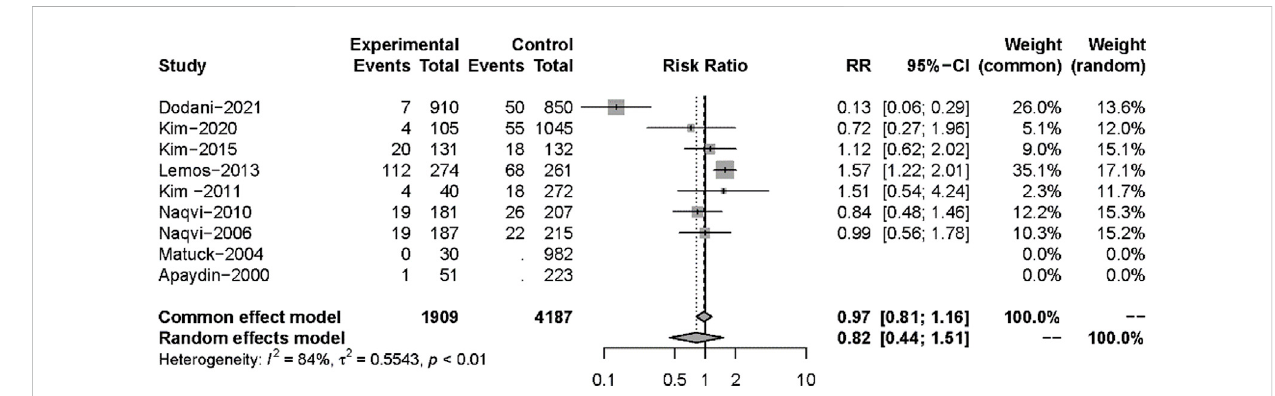
FIGURE 5 Forest plot for outcomes of acute rejection comparing isoniazid versus no treatment.